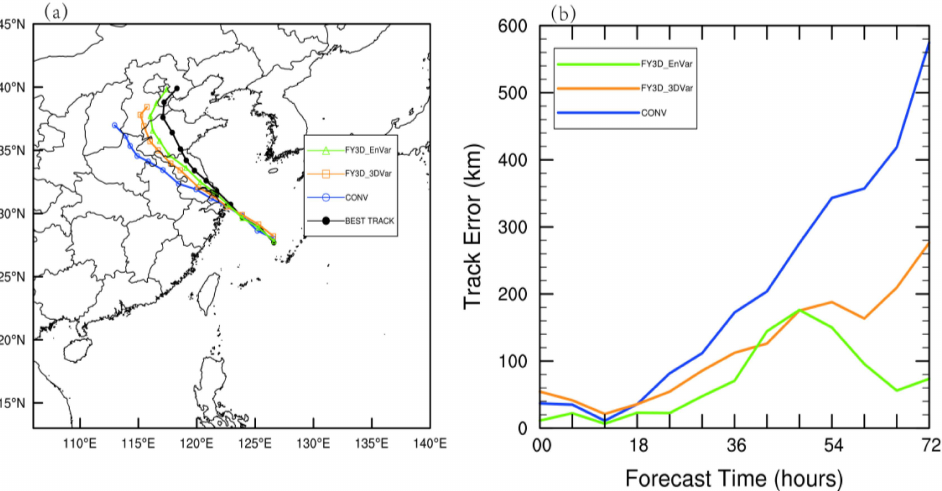
Figure 13. The deterministic 72-h forecast of ( a ) tracks and ( b ) track errors (unit: km) initialized from 0600 UTC on 21 July 2018.